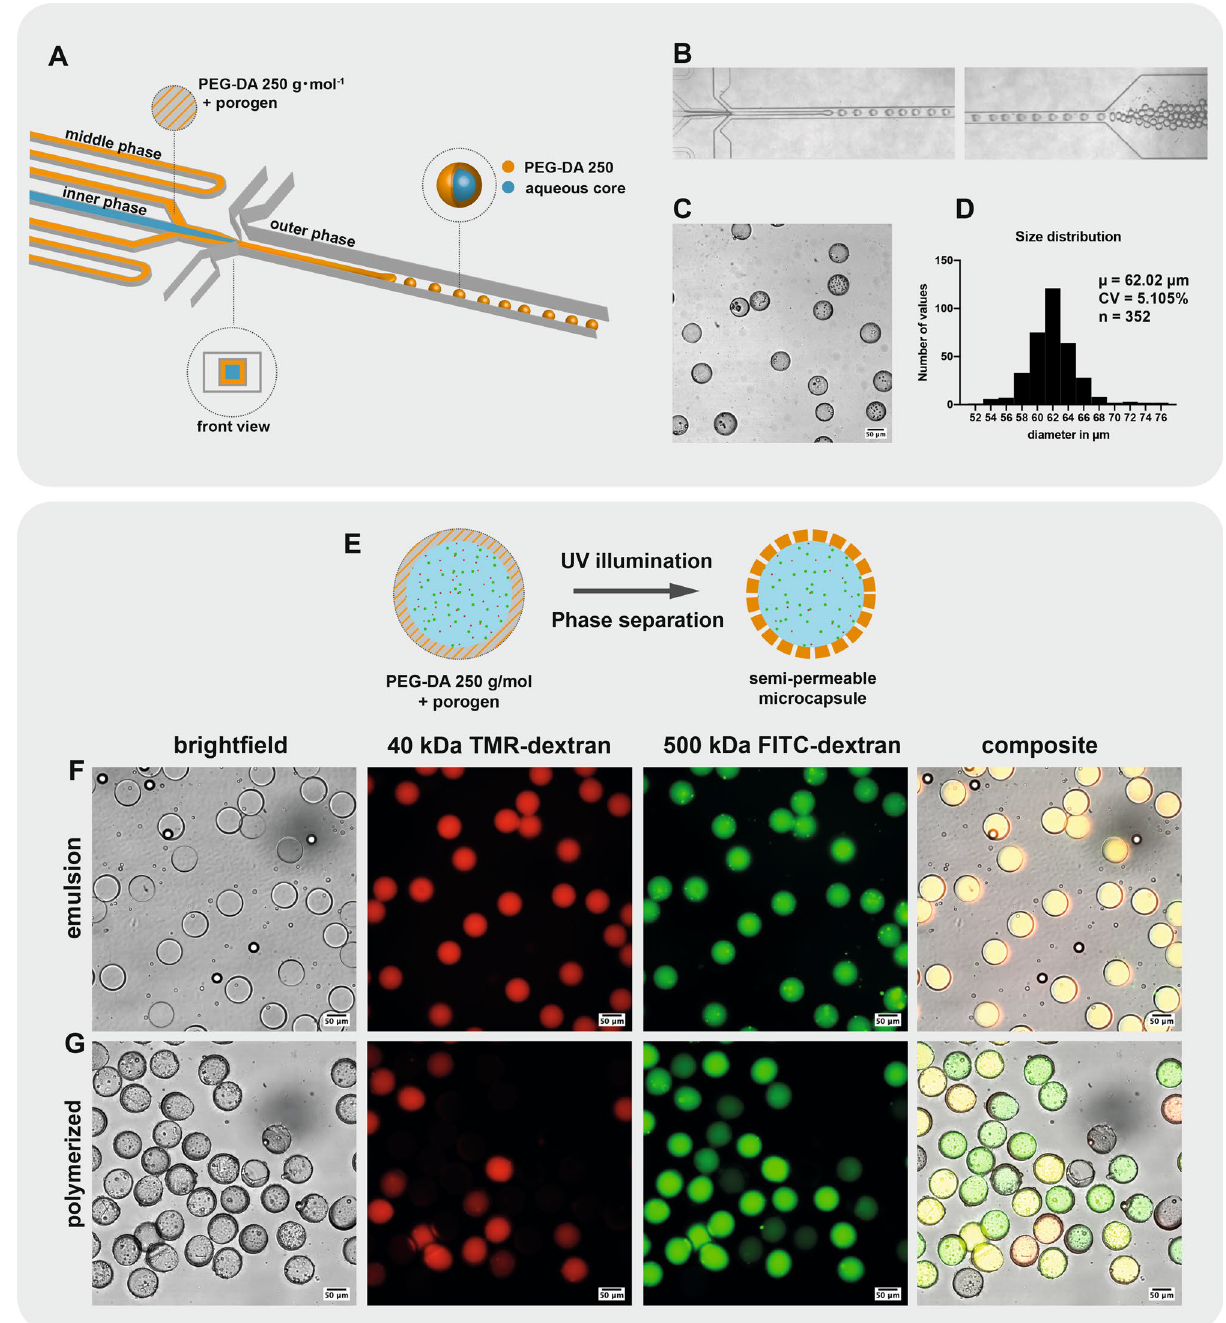
Figure 1. Production of semipermeable microcapsules in a PDMS device with 3D geometry. (A) Schematic representation of the PDMS device with 3D geometry. W/O/W double-emulsions are generated with a PEG-DA 258 middle phase encapsulating an inner aqueous core. (B) Micrographs of the PDMS device operation. (C) Brightfield image of microcapsules obtained after UV polymerization of the collected double-emulsion. (D) Size distribution of a representative batch of polymerized microcapsules. (E) Schematic representation of PIPS upon UV illumination. 15% Butyl-acetate (porogen) was mixed with PEG-DA 258 to form semi-permeable microcapsules. (F) In the collected double-emulsion, both high molecular weight 500 kDa FITC-dextran and lower molecular weight 40 kDa RITC-dextran are retained in the inner aqueous phase. (G) After UV polymerization and PIPS, pores are formed in the capsule shell and capsules become